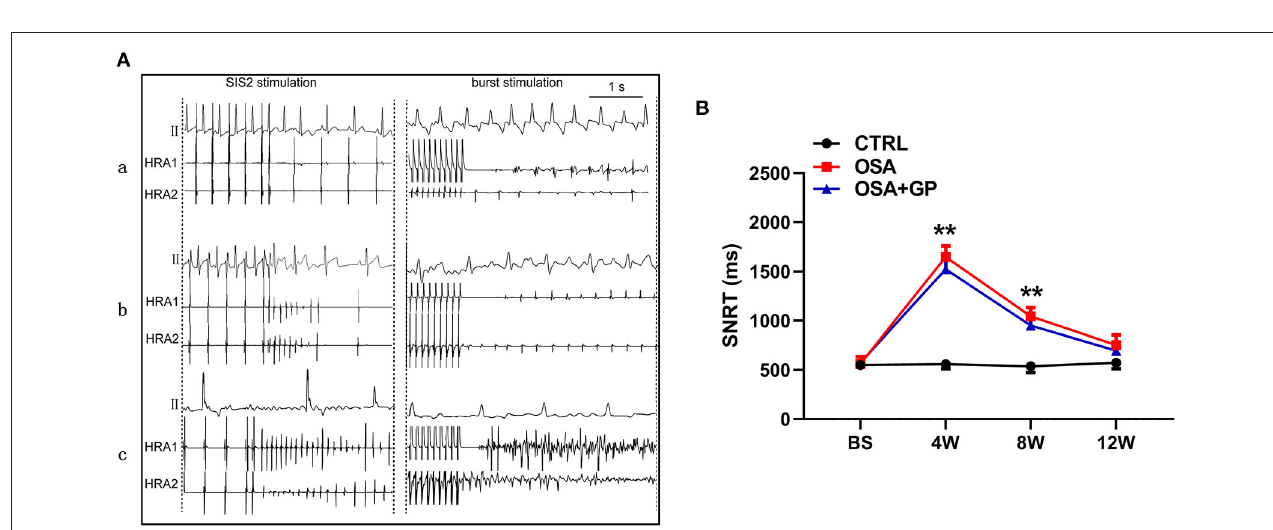
FIGURE 4 | (A) Typical examples of AF episodes induced by OSA after S1–S2 and burst stimulation among the three groups; (B) Changes in SNRT among the three groups. ** P < 0.01 vs. CTRL, n = 5. AF, atrial fibrillation; SNRT, sinus node recovery time; other abbreviations as in Figure 1 .